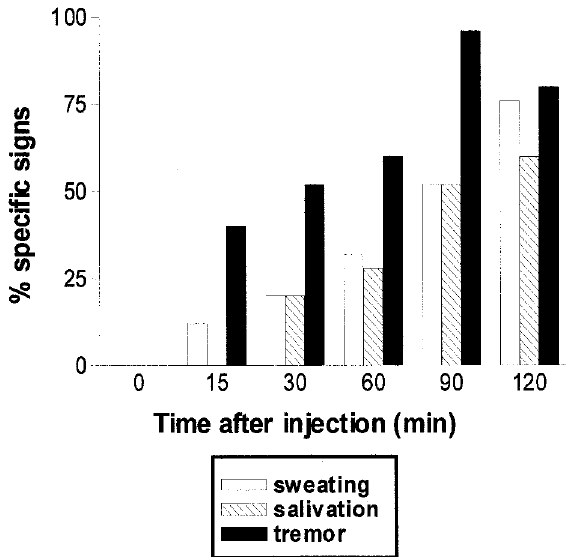
FIG. 1. Symptoms. Groups of 25 female mice from the BALB/ c strain, 16–20g of body weight, were injected i.p. with 1LD 50 of TSV. At different time intervals, the specific signs were observed. Each point represents the per cent animal number with symptoms.